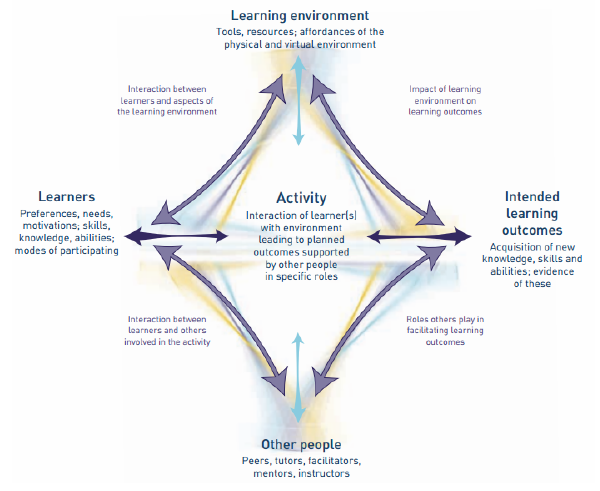
Figure 1. A model of learning activity design